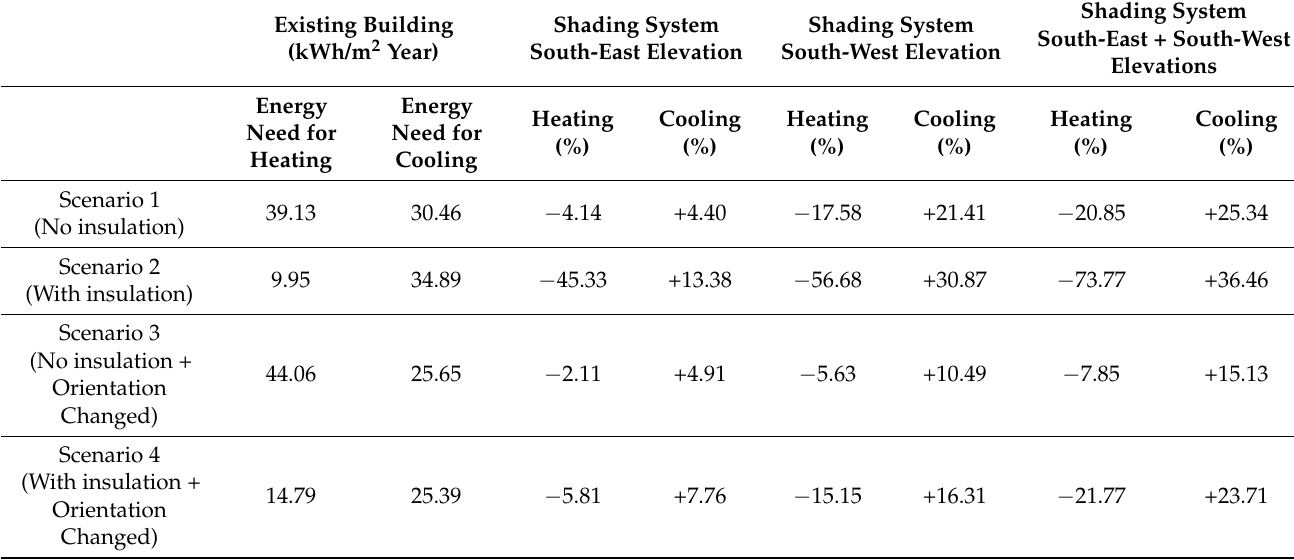
Table 1. Calculation of the improvement (%) of the shading system with the data obtained with HULC. Shading System Existing Building Shading System Shading System South-East + South-West (kWh/m 2 Year) South-East Elevation South-West Elevation